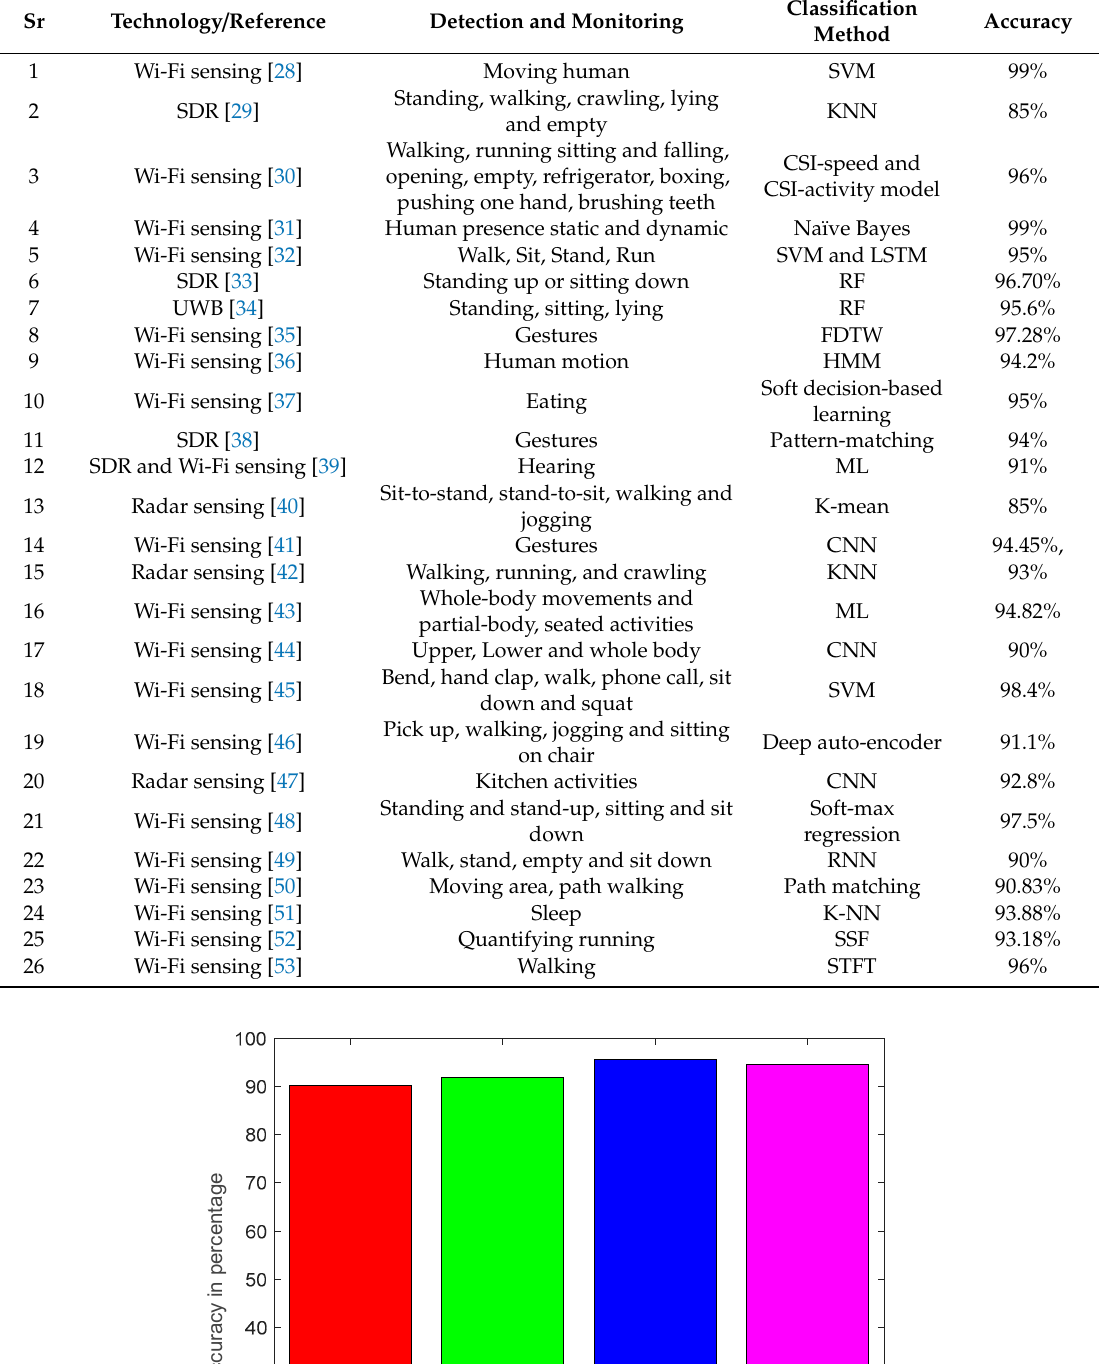
Table 3. Summary of existing contributions in human activity classification and monitoring.